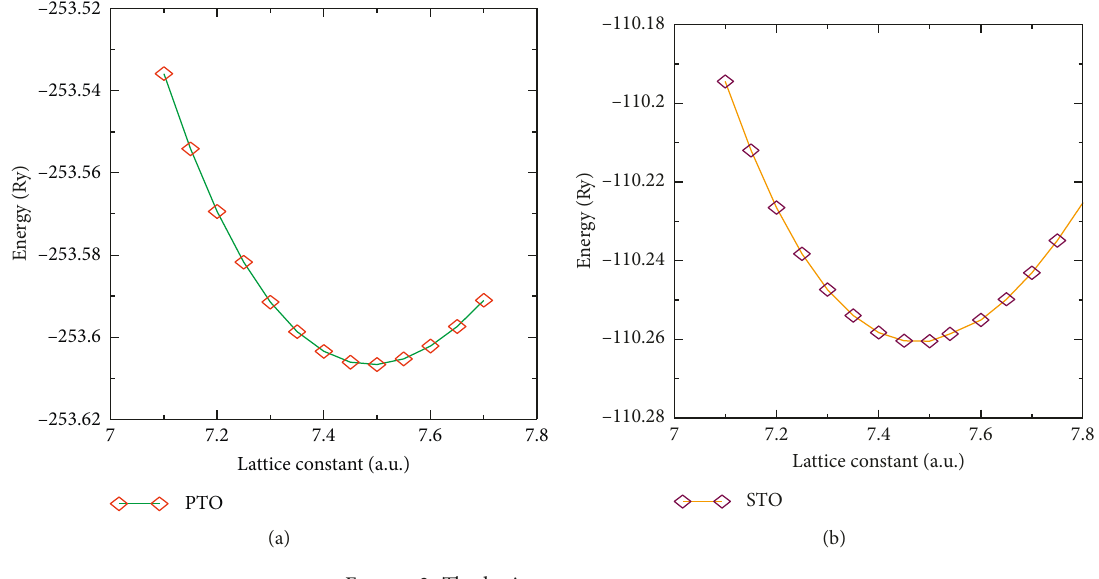
Figure 2: The lattice constant versus